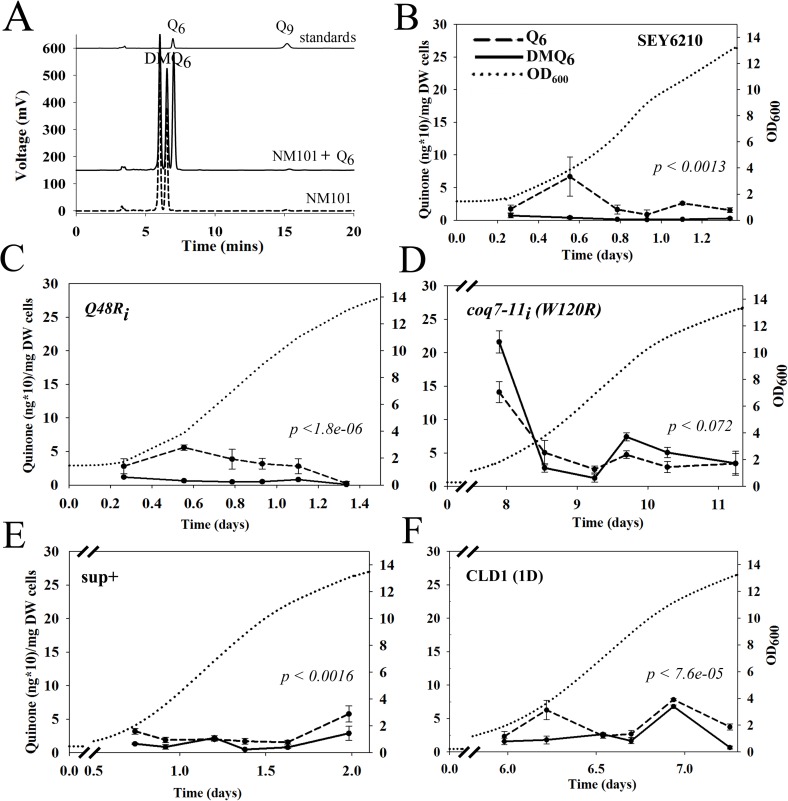
Effect of CLD1 Overexpression on Cellular Quinone Levels.(A) Quantitation of Q6 and DMQ6 levels in yeast whole-cell extracts using UV-HPLC. Three traces are offset on the vertical axis. Bottom trace: extract from loss-of-function NM101[coq7-1(G65D)] mutant containing DMQ6 (right peak); middle trace: extract from NM101 co-injected with Q6 standard; top trace: purified Q6 and Q9 standards. Q9 was added as an internal standard for all yeast quinone extractions. Peaks were detected using λ275nm. (B-F) UV-HPLC quantitation of Q6 (dashed line) and DMQ6 (solid line) in the indicated strains following growth in liquid YEPE3%. Quinone content is shown relative to culture density (OD600,
dotted line). Broken axes highlight the temporal difference in growth rate between strains (abscissa). (E) and (F) represent coq7-11i(W120R) yeast containing the indicated construct (see Fig 2C for details). Each data point is the average of three independent biological replicates and represents total (reduced + oxidized) Q6 and DMQ6. Error bars indicate standard deviation (See S3 Table for statistical analyses). p-values indicate strength of significance for whether Q6 and DMQ6 profiles differ (significance threshold after Bonferroni correction = 0.0038)